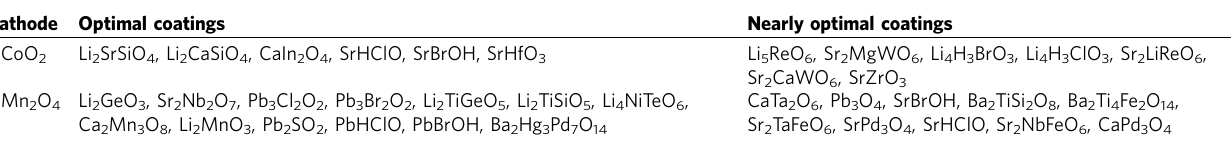
Table 2 | Optimal and nearly-optimal coatings for LiCoO 2 and LiMn 2 O 4 . Cathode Optimal